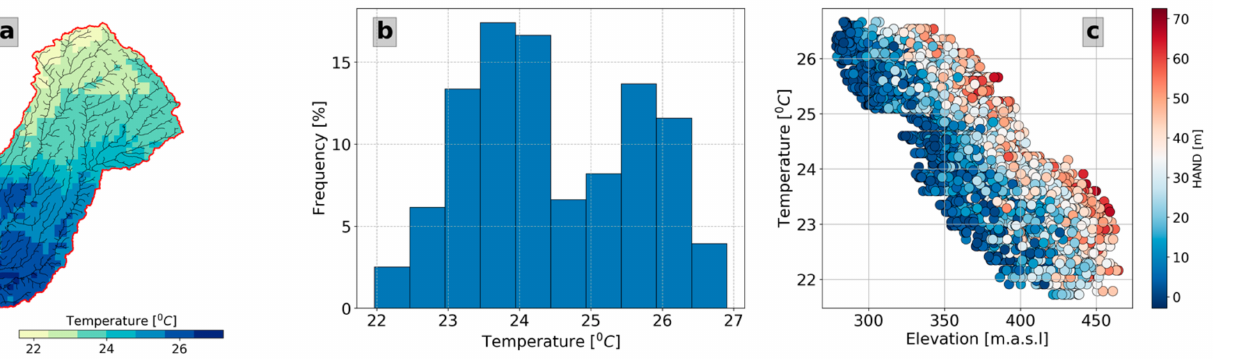
Figure 9. Analyzing temperature data in the watershed. ( a ) HRRR temperature spatial distribution along the watershed. ( b ) Histogram of the HRRR temperature. ( c ) Comparison between the elevation, temperature, and